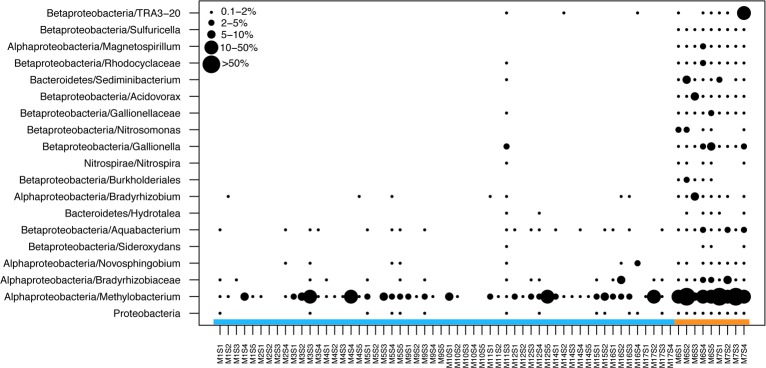
Dot plot showing the relative abundances of common (≥ 1%) bacterial OTUs that differed significantly by disinfection type (nested ANOVA, threshold P<0.01).Municipality was used as a nested variable. Colored bar along the x-axis indicates disinfectant type (blue = chlorine, orange = chloramine). Taxonomic identities are listed as phylum/genus or subphylum/genus for proteobacterial OTUs. Note the similarities between chloraminated samples and M11S3, which had exceptionally high iron.